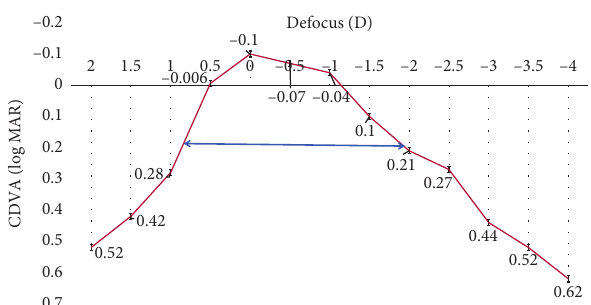
Figure 7: Defocus curve (distance corrected) at 6 months post-op.